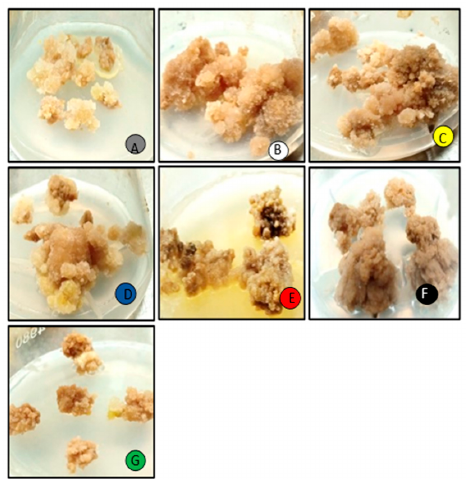
Figure 1. The morphological changes in the callus culture of M. oleifera kept under different monochromatic lights. (( A ) = Control; ( B ) = White; ( C ) = Yellow; ( D ) = Blue; ( E ) = Red; ( F ) = Dark; ( G ) = Green)).